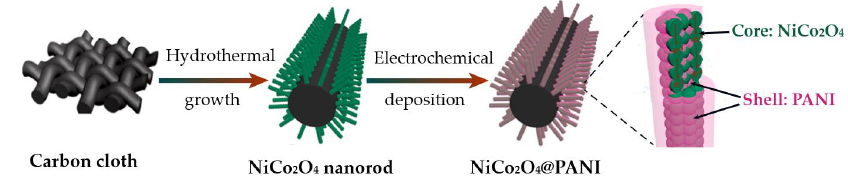
Figure 14. Schematic of the synthetic procedure for NiCo 2 O 4 @PANI nanorod arrays. Reprinted with permission from [134]. Copyright 2016, American Chemical Society.